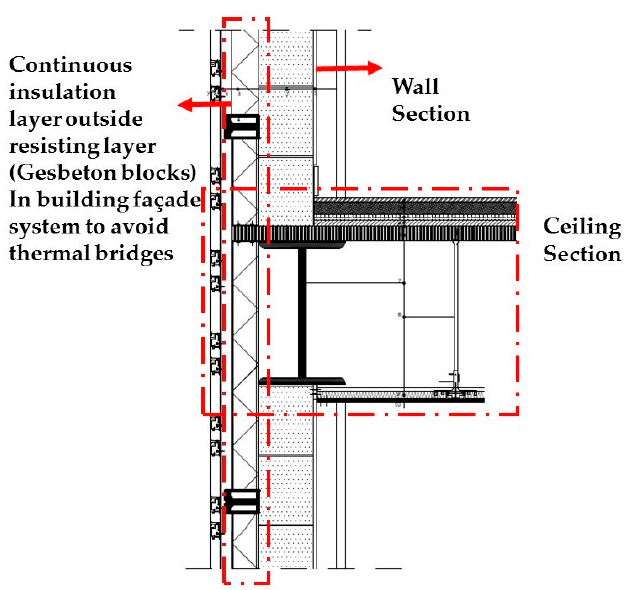
Figure 3. Insulation layer continuation in a wall section to avoid thermal bridges.